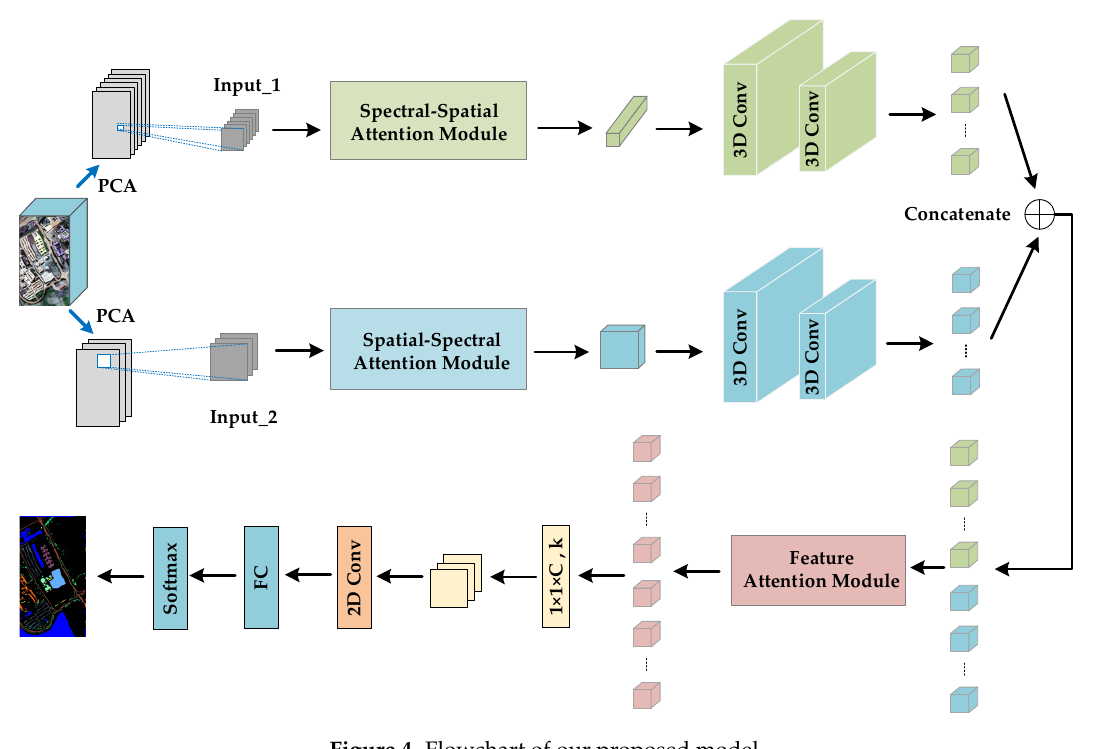
Figure 4. Flowchart of our proposed model.